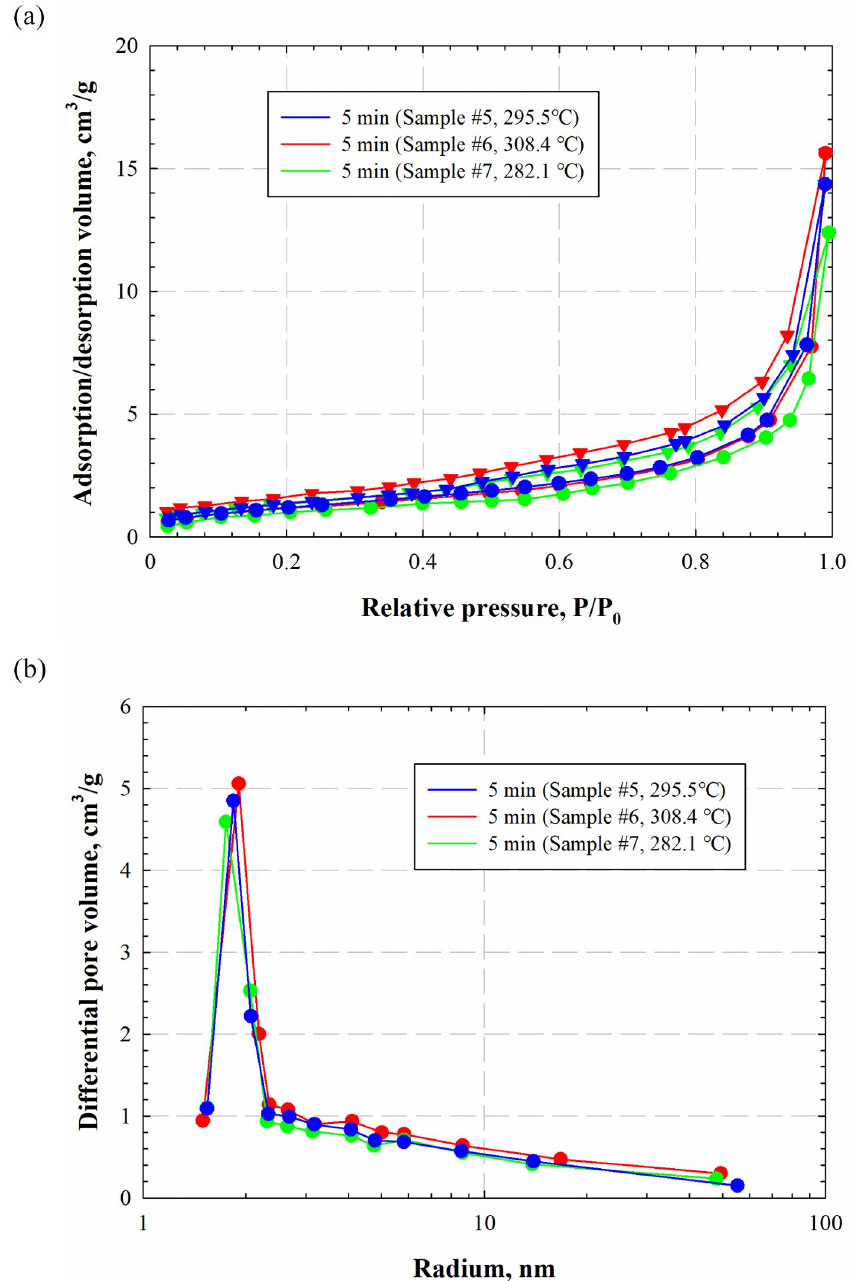
Fig 6. Comparison of the isothermals and pore-size distribution of samples #5–7.